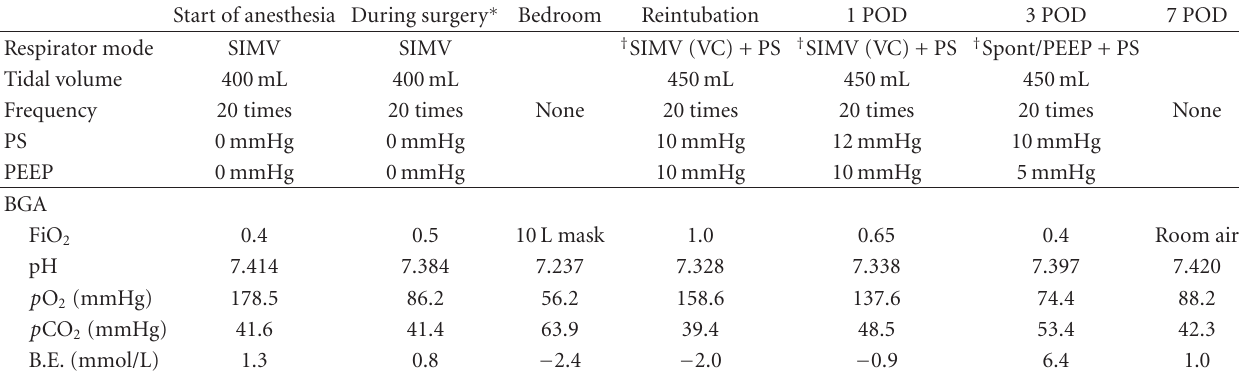
Table 1: Perioperative ventilatory support information and arterial blood gas analysis results. Start of anesthesia During surgery ∗